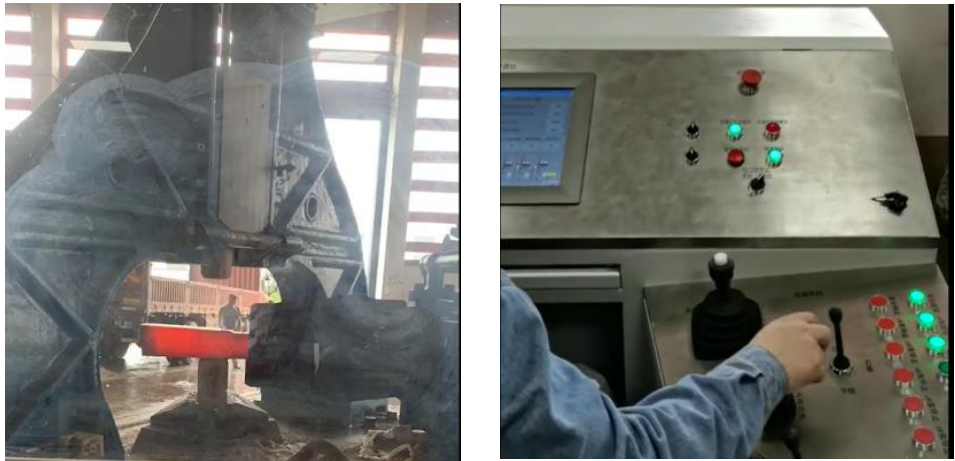
Figure 14. Experimental platform of 8 MN program-controlled free forging hammer.